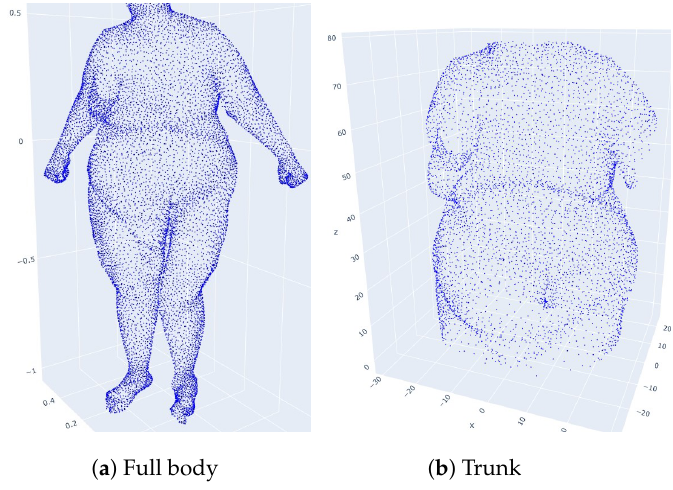
Figure 15. An individual and its isolated trunk. Table 1. Average GDI scores on the persistence diagrams of the whole body and the trunk with the Wasserstein distance.